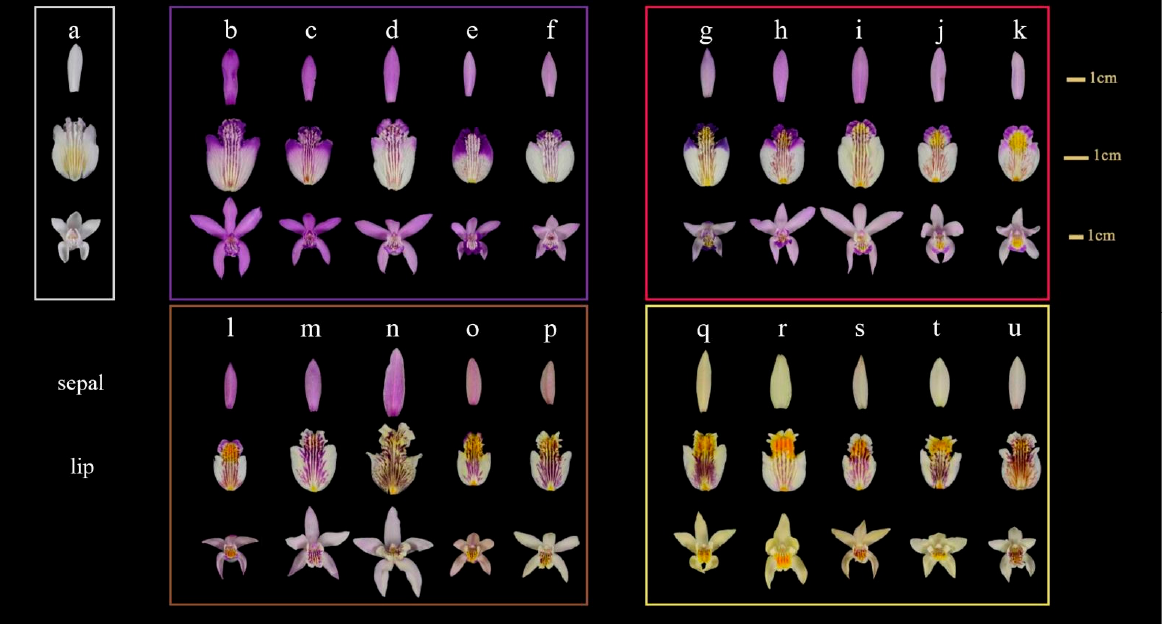
Figure 1. The phenotypic diversity of floral color in Bletilla of different origins. White group of B. striata (gW): a: Yunnan. Pure purple group of B. striata (gP): b: Qinling, c: Shanghai, d: Japan, e: Wuhu, f: Wuhan. Purple perianth yellow lip group of B. striata (gPY): g: Shanghai, h: Shanxi, i: Hubei, j: Enshi, k: America. Purple perianth group of B. ochracea (gYP): l: Guiyang, m: Liuba, n: Chongqing, o: Liuba, p: Shangluo. Pure yellow group of B. ochracea (gY): q: Sichuan, r: America, s: Jingxi, t: Guizhou, u: Liuba.